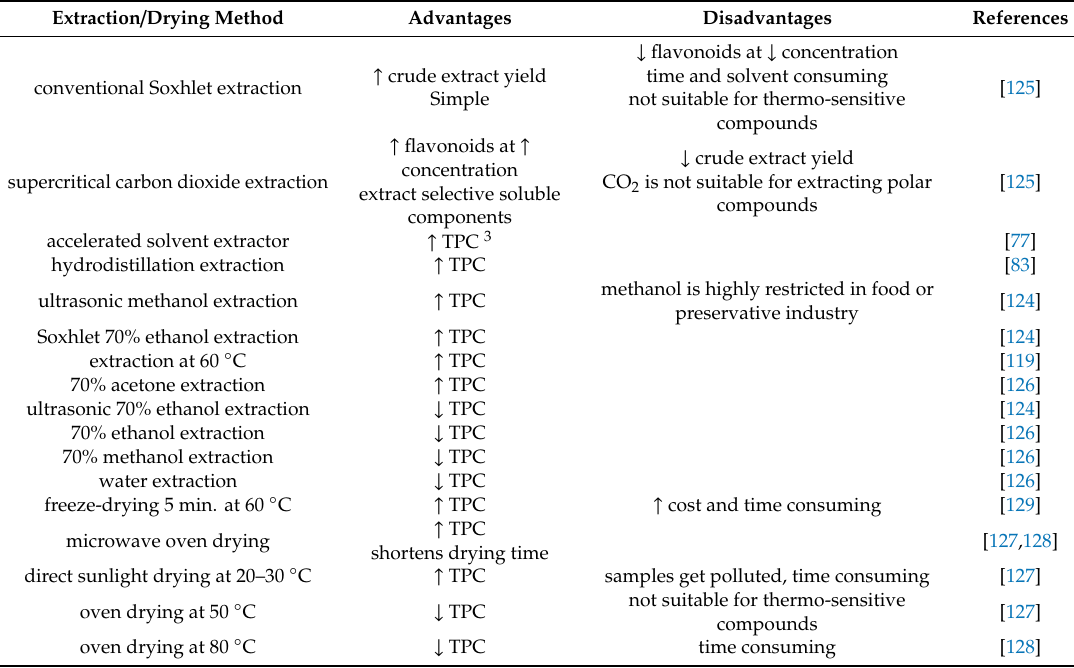
Table 2. E ff ect of extraction and / or drying methods on the phenolic